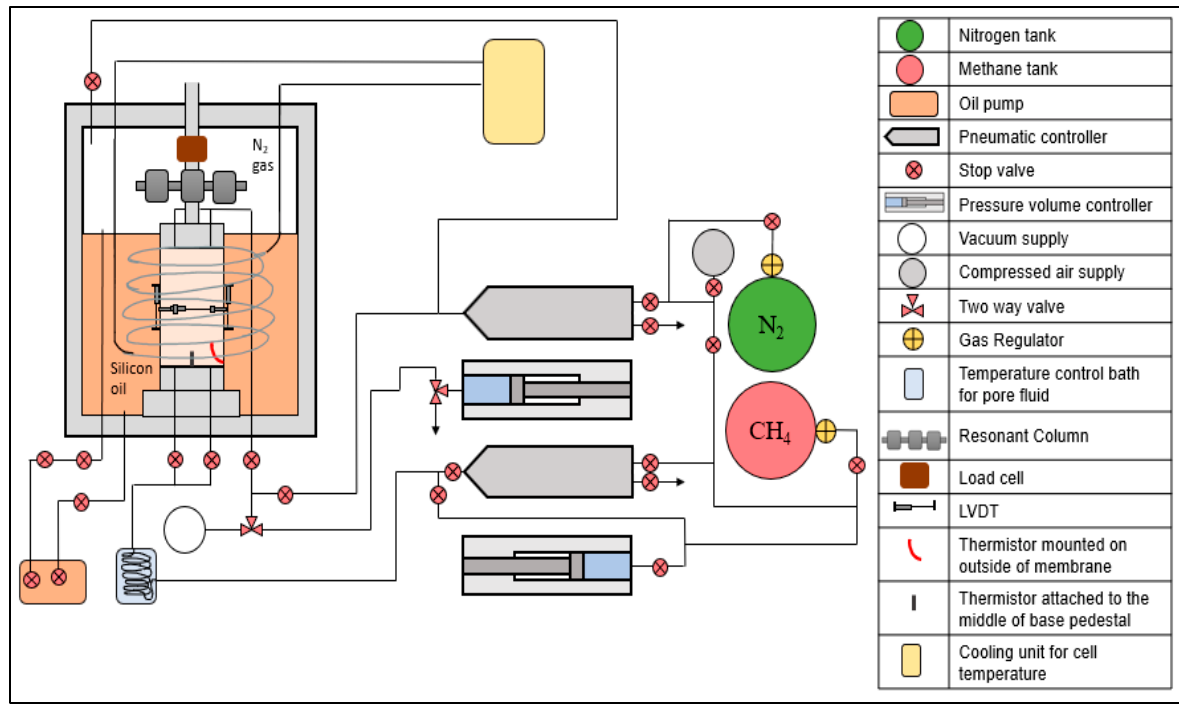
Figure 1. Schematic of ETAS and its components for the testing of hydrate-bearing specimens.